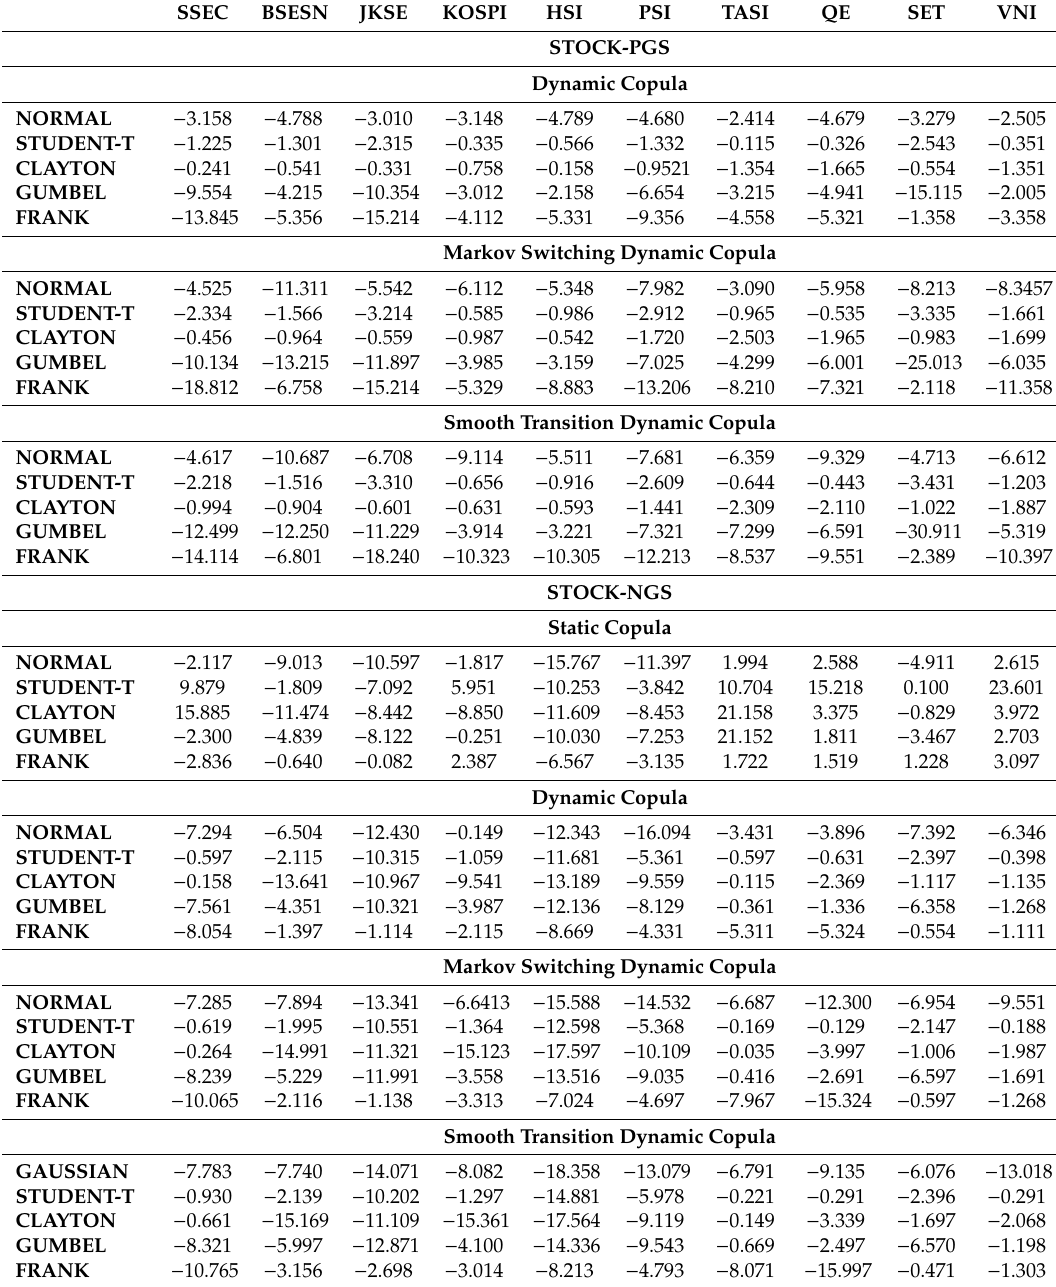
Table 9. AIC of three time-varying Copula models for the twenty